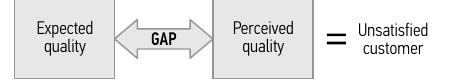
Fig. 2. Expected quality is higher than perceived quality